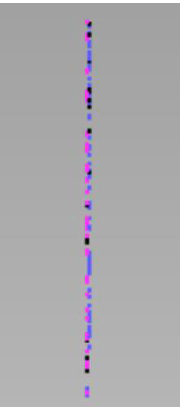
Figure 8. Illustration of the points of the three edges